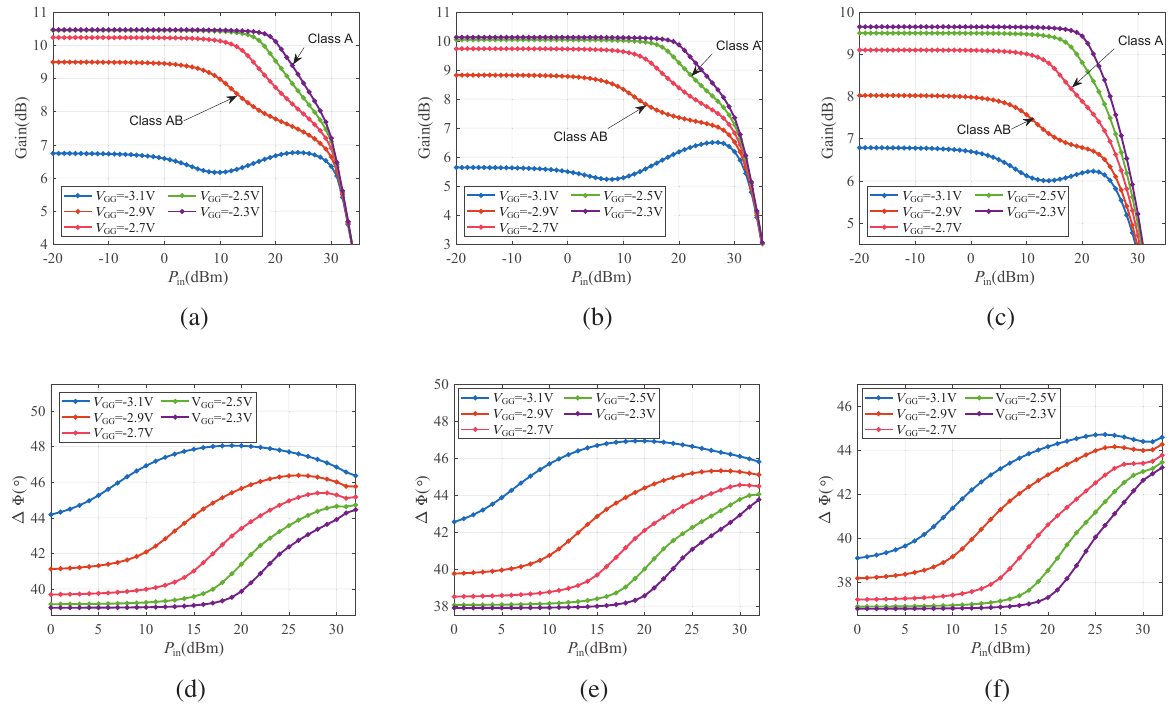
Figure 5. Advanced Design System (ADS) simulated AM/AM curves of the GaN PA: ( a ) V DD = 28 V, ( b ) V DD = 20 V, ( c ) V DD = 12 V, and AM/PM curves; ( d ) V DD = 28 V, ( e ) V DD = 20 V, and ( f ) V DD = 12